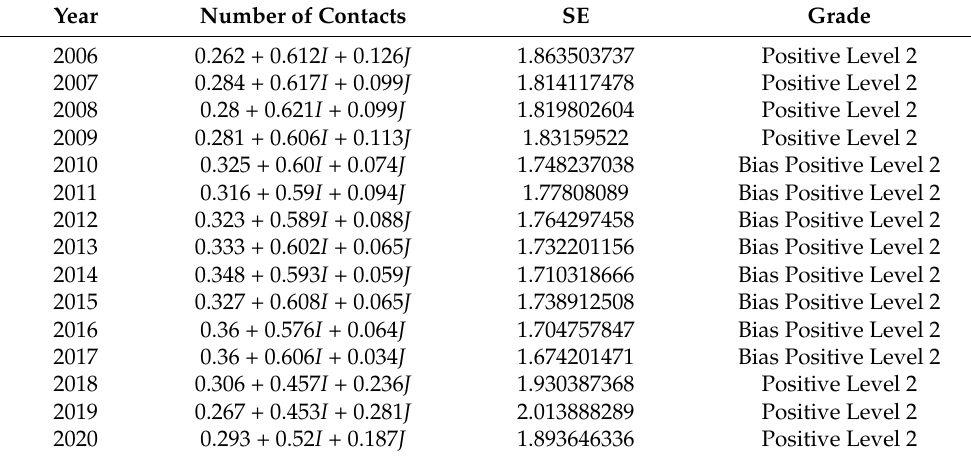
Table 4. Set pair potential